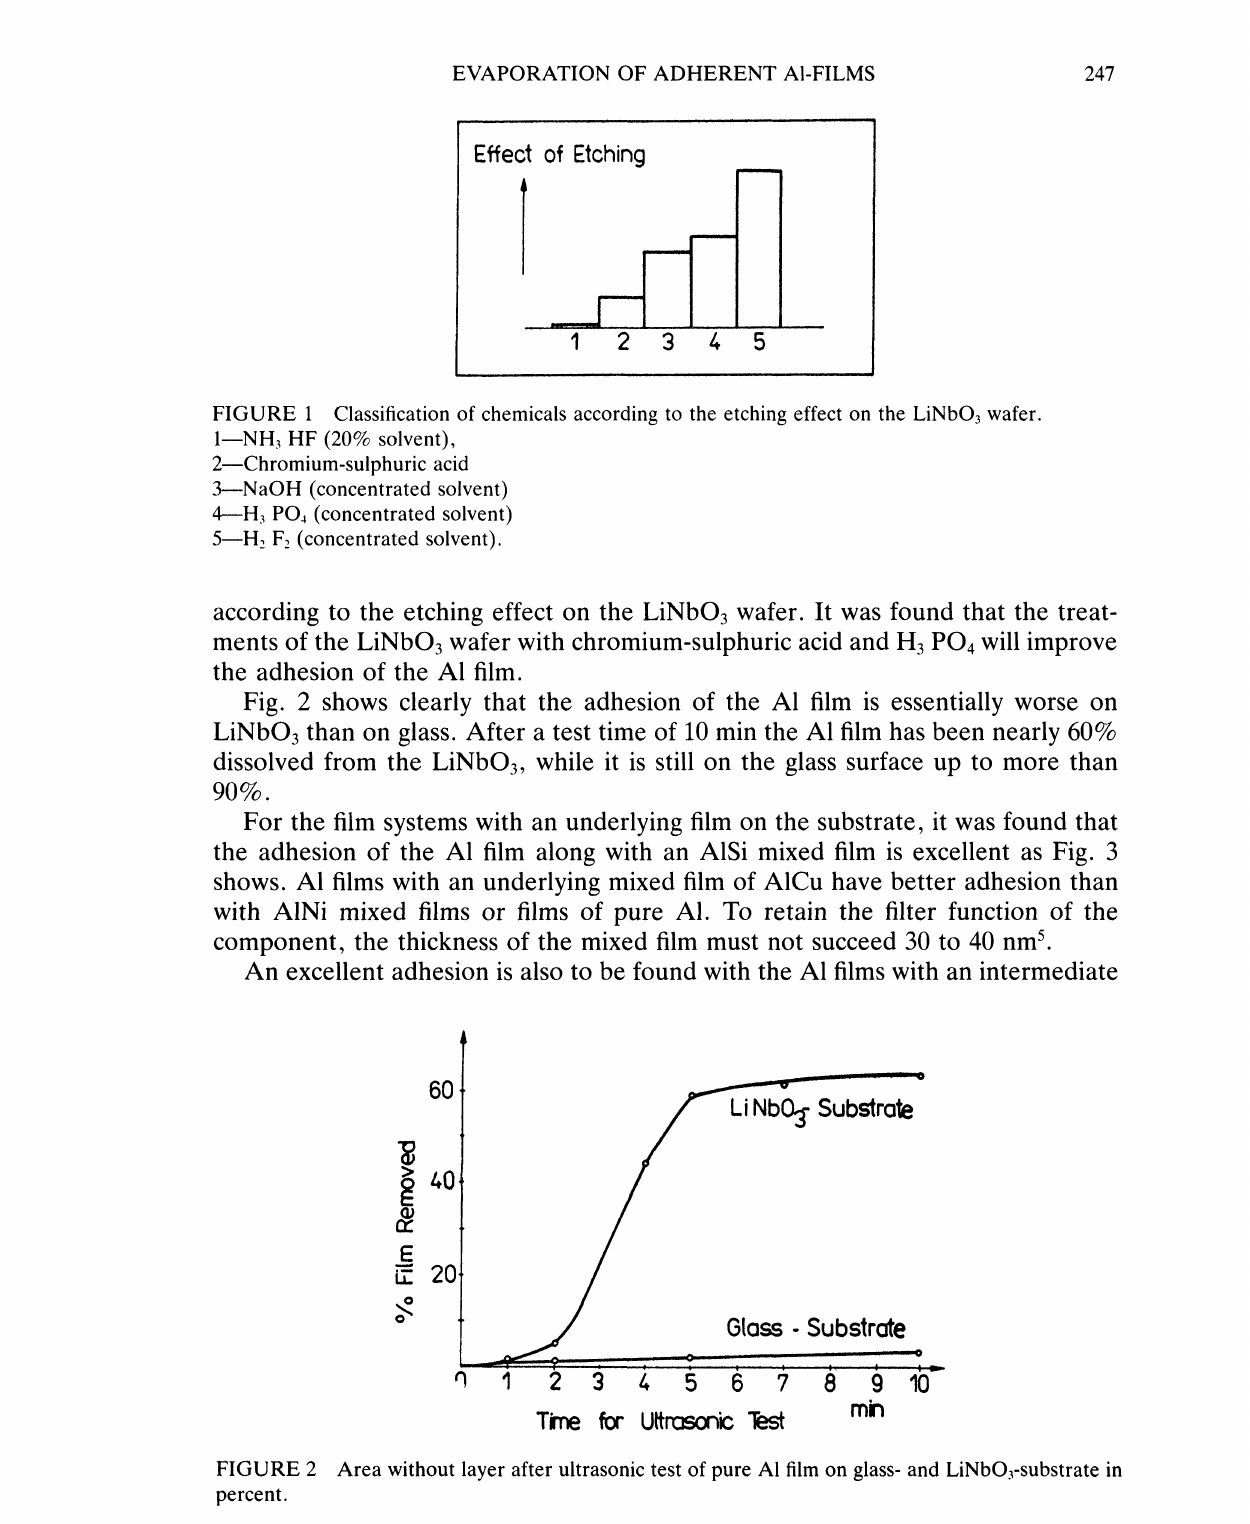
FIGURE 2 Area without layer after ultrasonic test of pure AI film on glass- and LiNbO3-substrate in